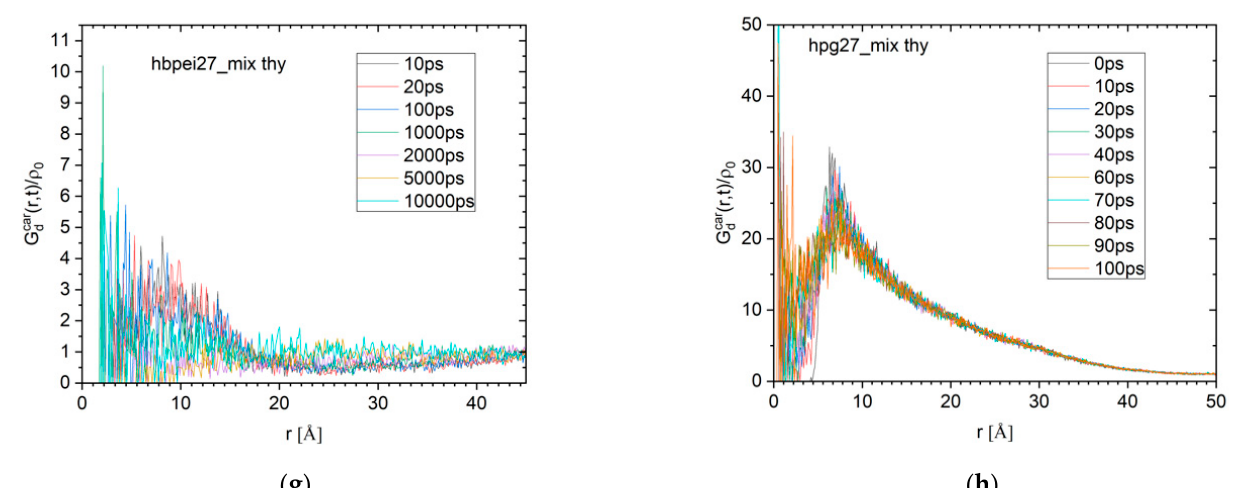
Figure 6. Distinct van Hove functions for ( a ) carvacrol, ( b , c ) p-cymene, ( d , e ) γ -terpinene, and ( f , g ) thymol in ( h ) systems with HBPEI (left) and HPG (right) and terpenoid mixtures in realistic proportions (27:189:18:15:7 and 27:270:26:22:10, respectively). Statistical noise arises with a smaller number of drug molecules. The distinct van Hove spectra are normalized by the overall density of the examined molecules.